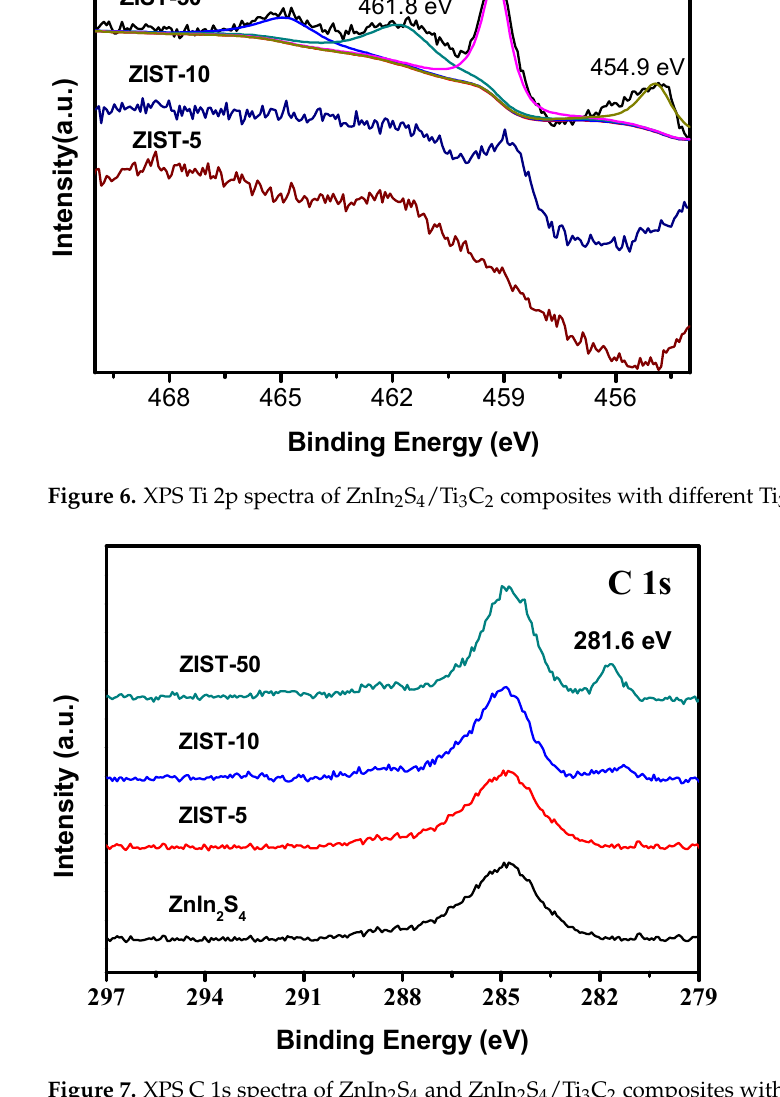
Figure 7. XPS C 1s spectra of ZnIn 2 S 4 and ZnIn 2 S 4 /Ti 3 C 2 composites with different Ti 3 C 2 content.